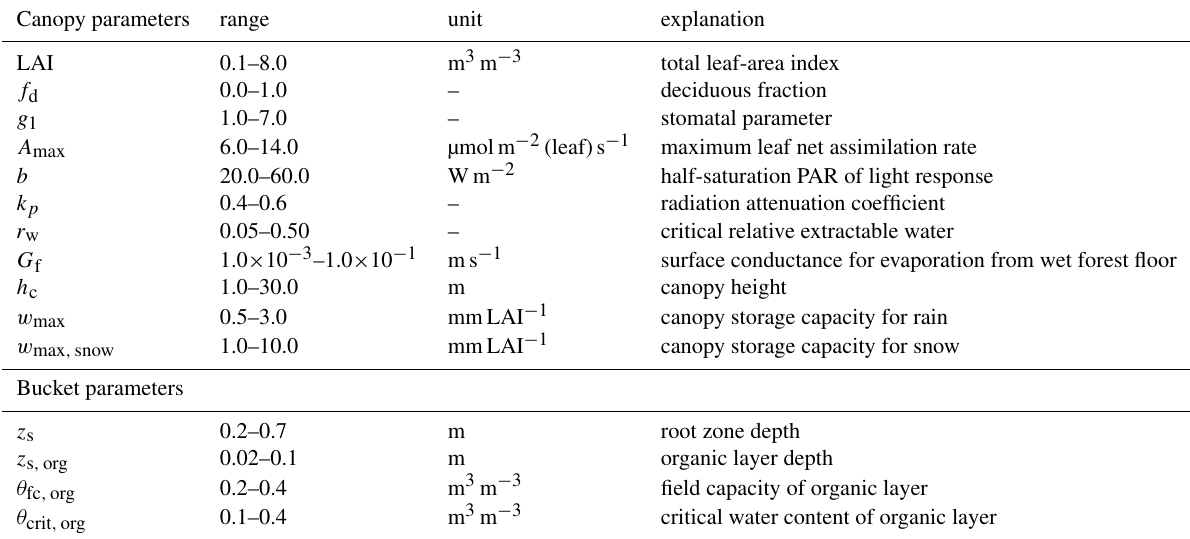
Table 3. Parameters and their ranges used in the global sensitivity analysis (Morris method) at stand scale. Canopy